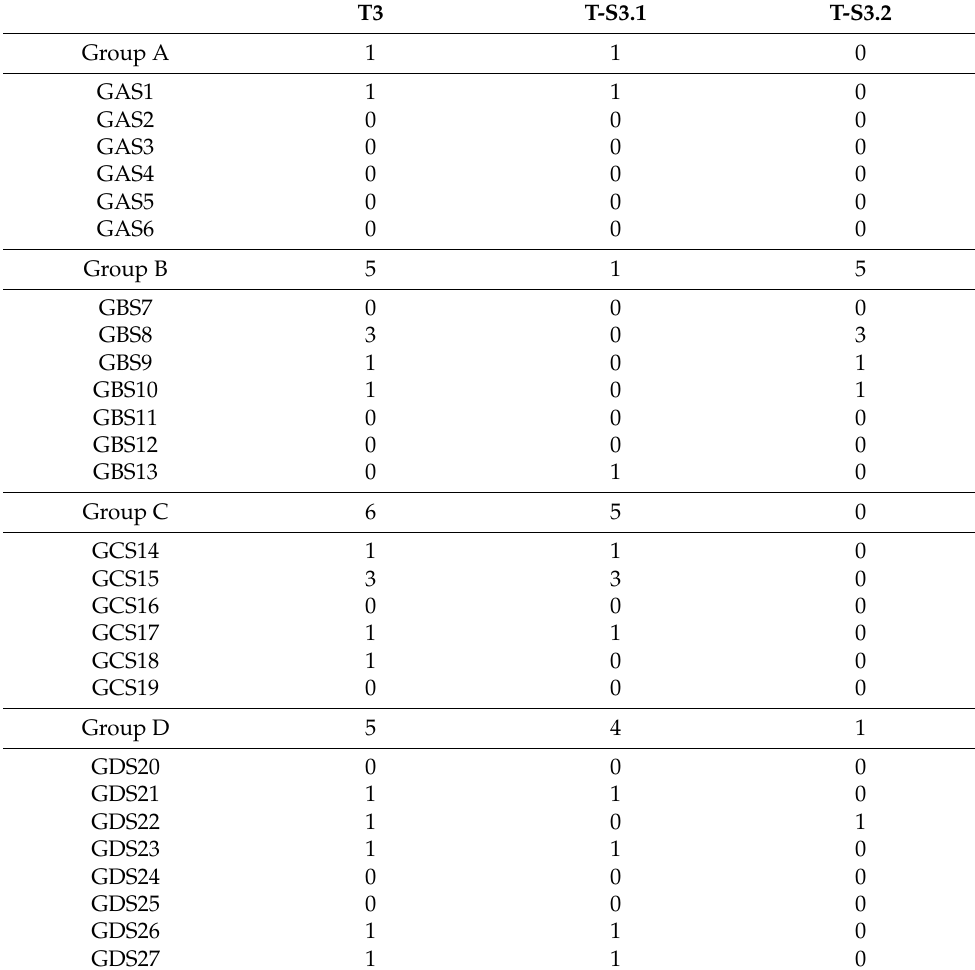
Table 5. Distribution of occurrences per participant on the theme 3 (T3) and the related sub-themes (S-T3.1, S-T3.2) (Table 2).